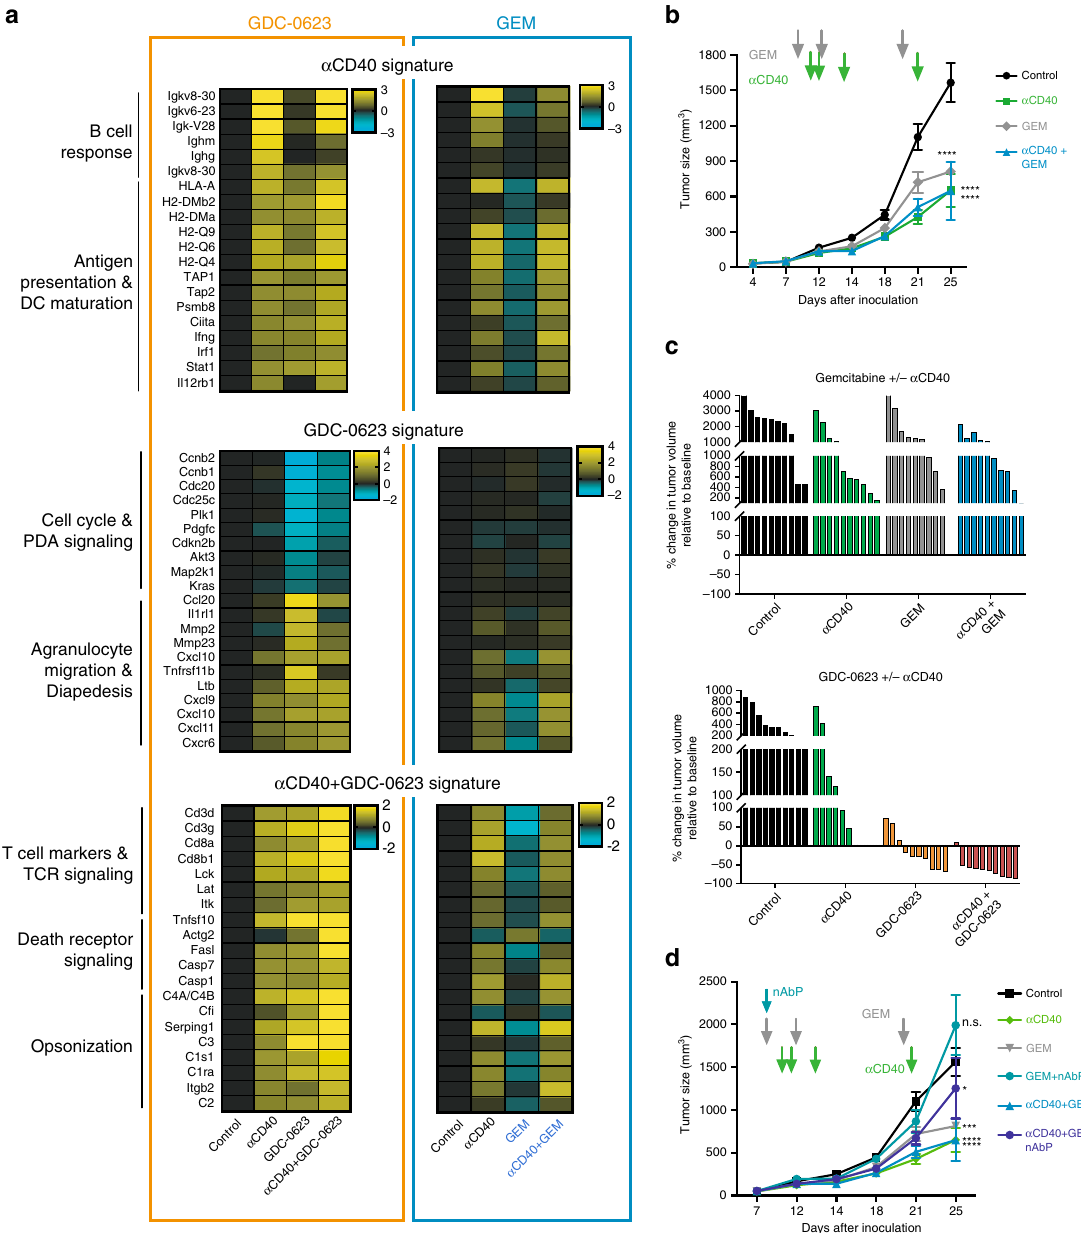
Fig. 7 Gene signatures correlate with treatment ef fi cacy and reveal drug mechanism of action. a Gene signatures for each individual treatment regimen manually composed on the basis of differentially expressed genes between control and indicated treatment group of the MEKi/CD40 Ab experiment, as performed on four mice per treatment group of the experiments shown in Fig. 3a – c. In GEM/CD40 Ab PDA30364 experiments, 120 mg kg − 1 GEM was administered on treatment days 1, 5, and 12 and anti-CD40 Ab on days 3, 4, 6, and 14; mean ± s.e.m. Each treatment group consisted of at least seven animals. Four mice per treatment group were analyzed on day 22/23 after tumor inoculation. b Tumor growth of GEM/CD40 Ab or monotherapy groups. Mean±s.e.m. Two-way ANOVA with post hoc Fisher ’ s LSD test (treatment groups vs. control; day 25). c Waterfall plots of GEM/CD40 Ab and MEKi/anti- CD40 Ab on day 22 after tumor inoculation. Each bar represents one individual mouse. Some data as in Fig. 3c and 7b. d Treatment of PDA30364 tumor- bearing mice with 120 mg kg − 1 GEM or nanoparticle albumin bound paclitaxel (nAbP). nAbP was administered on treatment day 1 and GEM was dosed on days 1, 5, and 12. Anti-CD40 Ab on days 3, 4, 6, and 14. Mean± s.e.m. Four mice per treatment group were sacri fi ced on days 22/23 after tumor inoculation. Note, the control, anti-CD40 Ab, GEM, GEM/anti-CD40 Ab groups are the same as in b . Two-way ANOVA with post hoc Fisher ’ s LSD test (treatment groups vs. control; day 25). Signi fi cance levels are indicated by asterisks (* p ≤ 0.05; ** p ≤ 0.01; *** p ≤ 0.001; **** p ≤ antitumor ef fi cacy 14 , also did not result in synergistic antitumor the cell cycle and biosynthesis signature. Furthermore, whereas ef fi cacy in our PDA30364 model (Fig. 7d). The difference in MEKi single-agent treatment induces multiple pro-immunogenic antitumor ef fi cacy between the two treatments is closely re fl ected pathways, these are all markedly suppressed in GEM single-agent- by differences in the gene signatures. In particular, the GEM and treated tumors. Finally, the synergy in induction of T cell markers GEM/CD40 Ab regimens fail to induced a strong suppression of by the MEKi/CD40 Ab combination is not observed for the GEM/